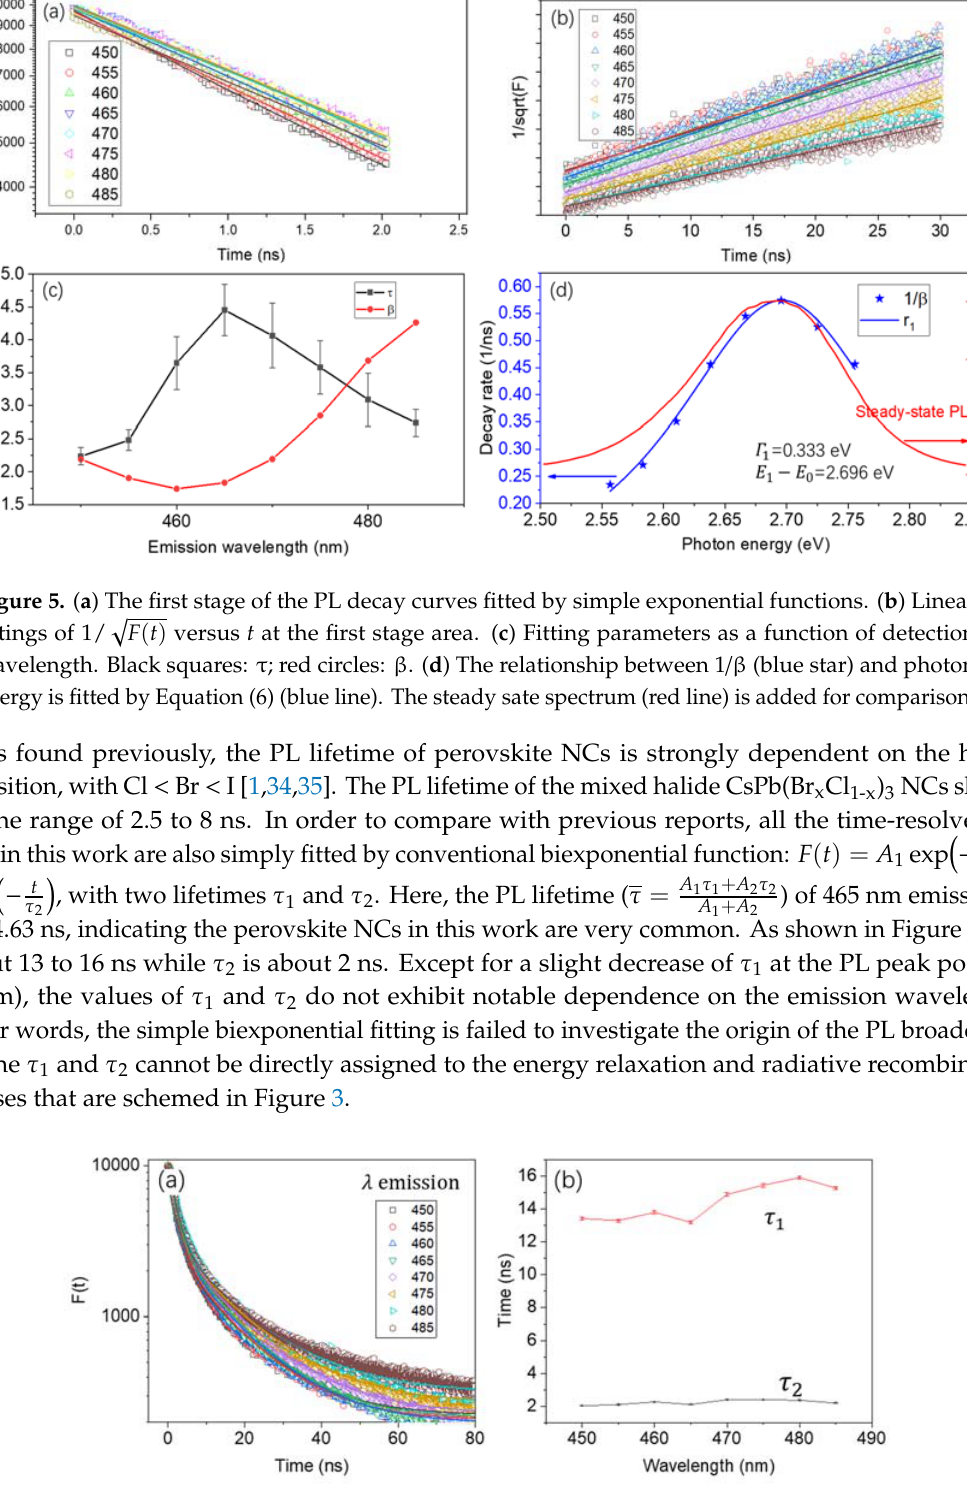
Figure 6. ( a ) Biexponential function fittings of the PL decay curves monitored at di ff erent wavelengths. ( b ) The two lifetimes τ 1 and τ 2 acquired by biexponential function fittings.